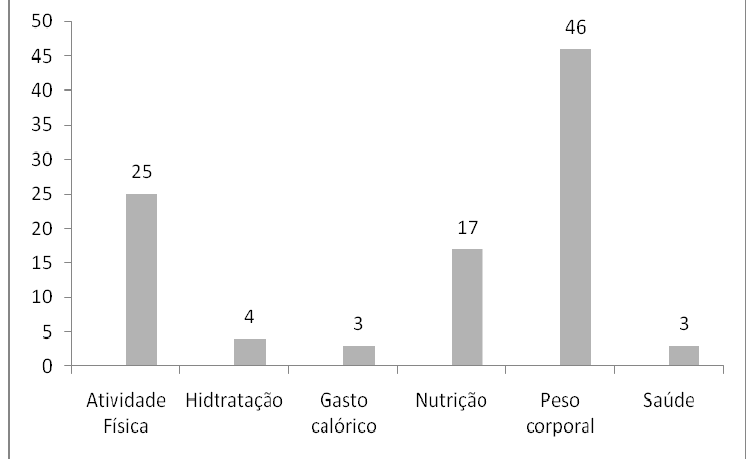
Figura 3. Gráfico representando ocorrência das